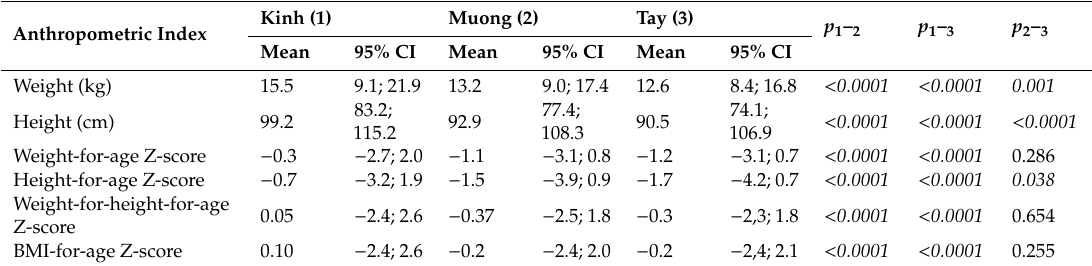
Table 2. Main anthropometric indices of three ethnic groups.